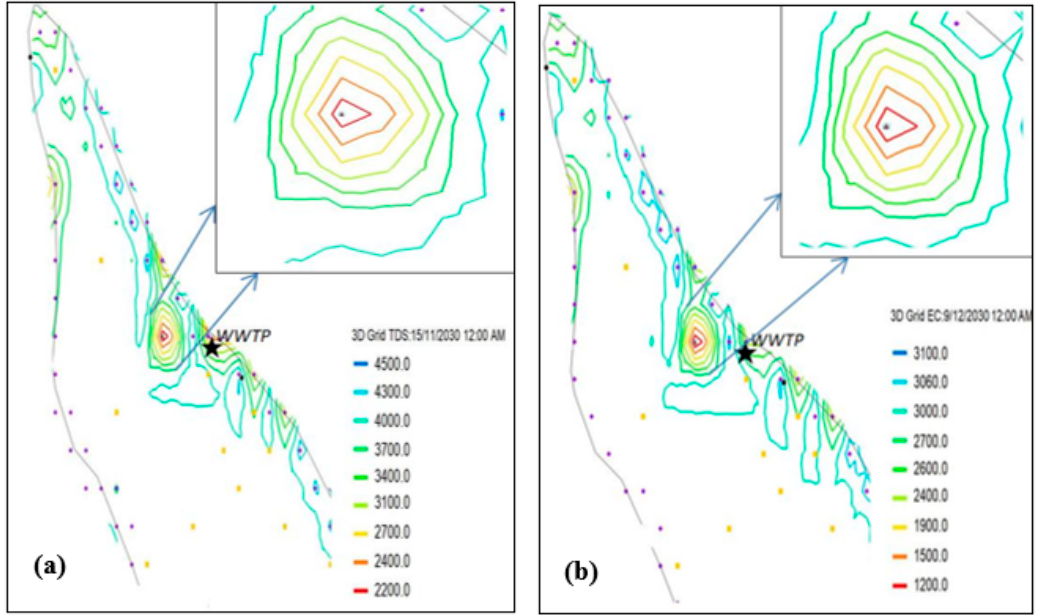
Figure 9. Effect of the artificial recharge on water quality under SIM2 simulation model ( a ) TDS and ( b ) EC for the period 2022–2030.